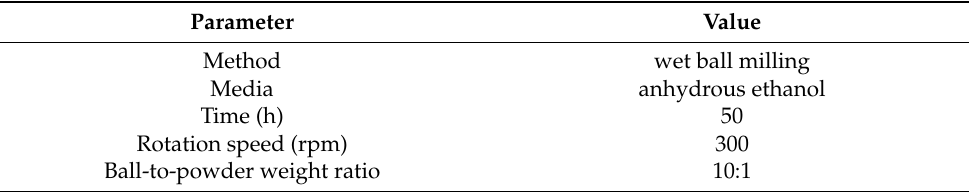
Table 1. Ball mill process parameters of Al 0.25 FeNiCoCr powders.